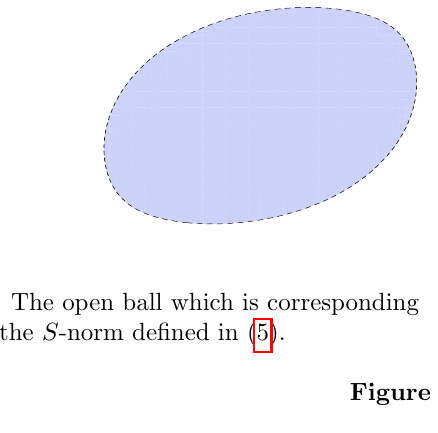
Figure 1. Some open balls in ( R 2 , ∥ ., ., . ∥